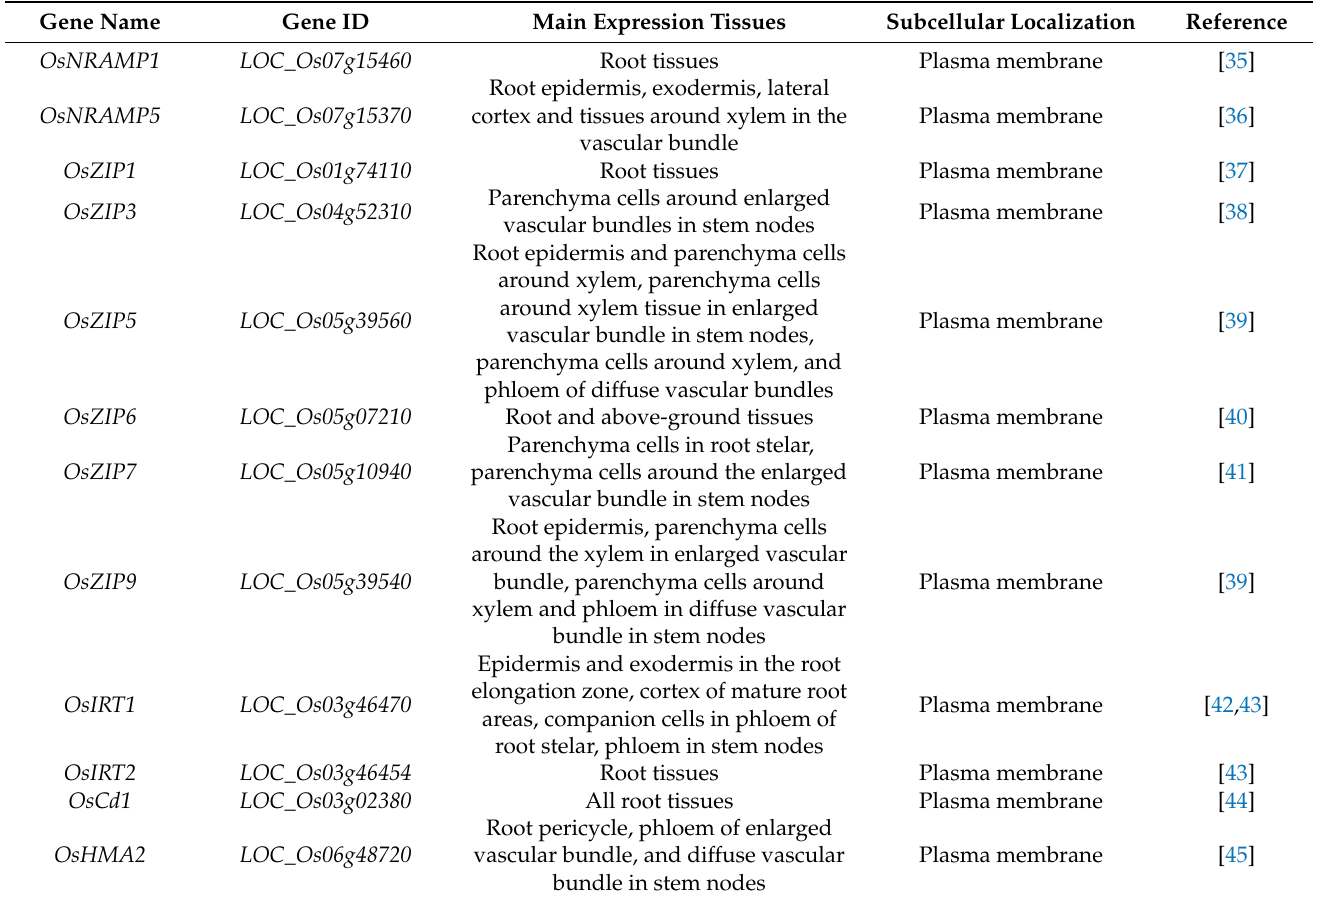
Table 1. Transporters and genes encoding transporters related to Cd accumulation in